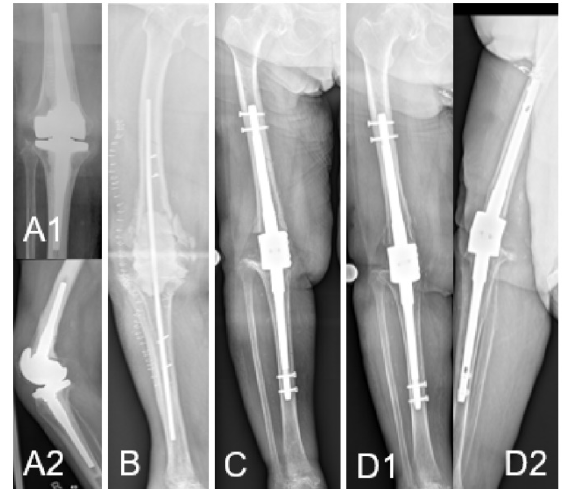
Figure 1. (A) Pre-operative X-ray with knee revision arthroplasty with cemented femoral and tibial stem anchorage without any obvious signs of loosening or osteolysis (A1: ap, A2: lateral). (B) After removal of the revision prosthesis intramedullary rods are placed in the femur and tibia with an antibiotic-loaded PMMA spacer to fill the large dead space as interim knee arthrodesis solution. Cortical windows were needed for complete bone cement removal, which were then fixed with screws. (C) Postoperative ap-view after modular knee arthrodesis with metallic silver coating and connection of the intramedullary femoral and tibial components with a spacer and locking bolts. Intramedullar rods were fixed cementless. (D) 26 months control after